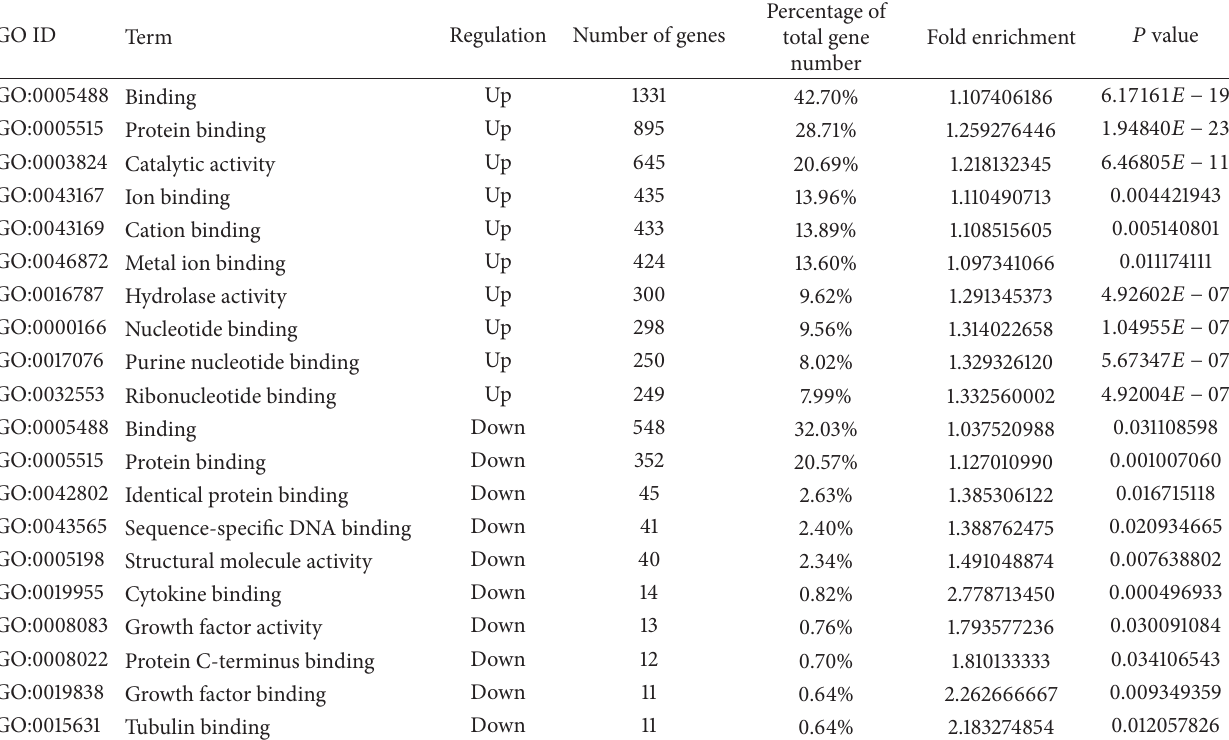
Table 5: GO analysis of RA SMSCs with different molecular functions related to differentially expressed genes.